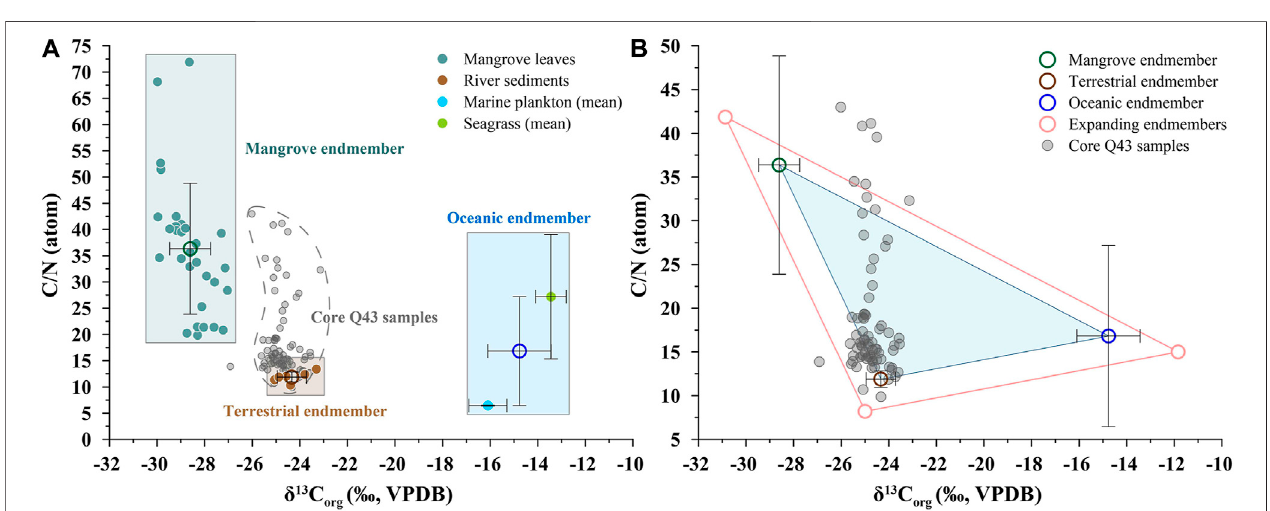
Frontiers in Earth Science |